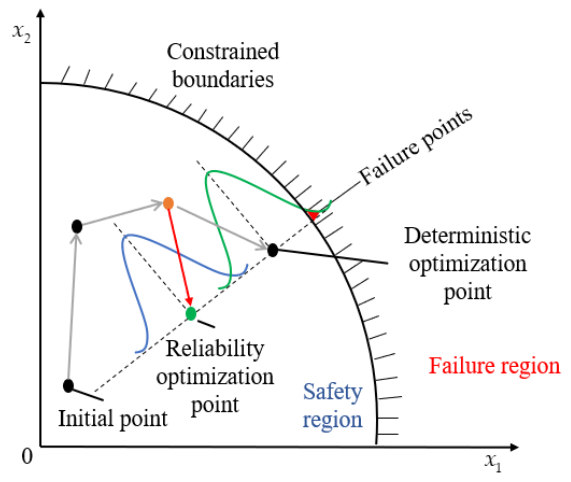
Figure 2. Reliability optimization diagram.